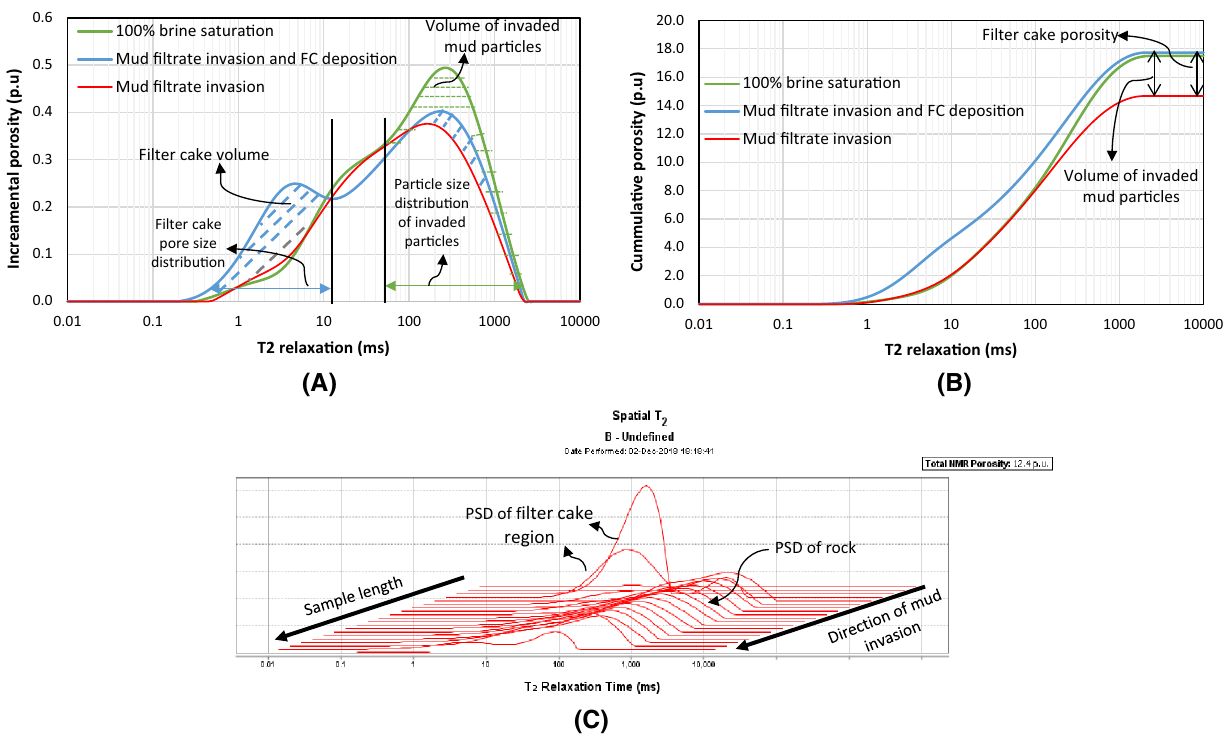
Fig. 8 Sample 2 ( A ) PDF of NMR T Corresponding cumulative pore sizes (porosity) for the different sam- 2 relaxation showing the pore ple states. ( C ) Spatial pore size distribution along the sample size distribution at 100% KCl saturation (green), after mud invasion and filter cake deposition (blue), and after removal of filter cake. ( B )